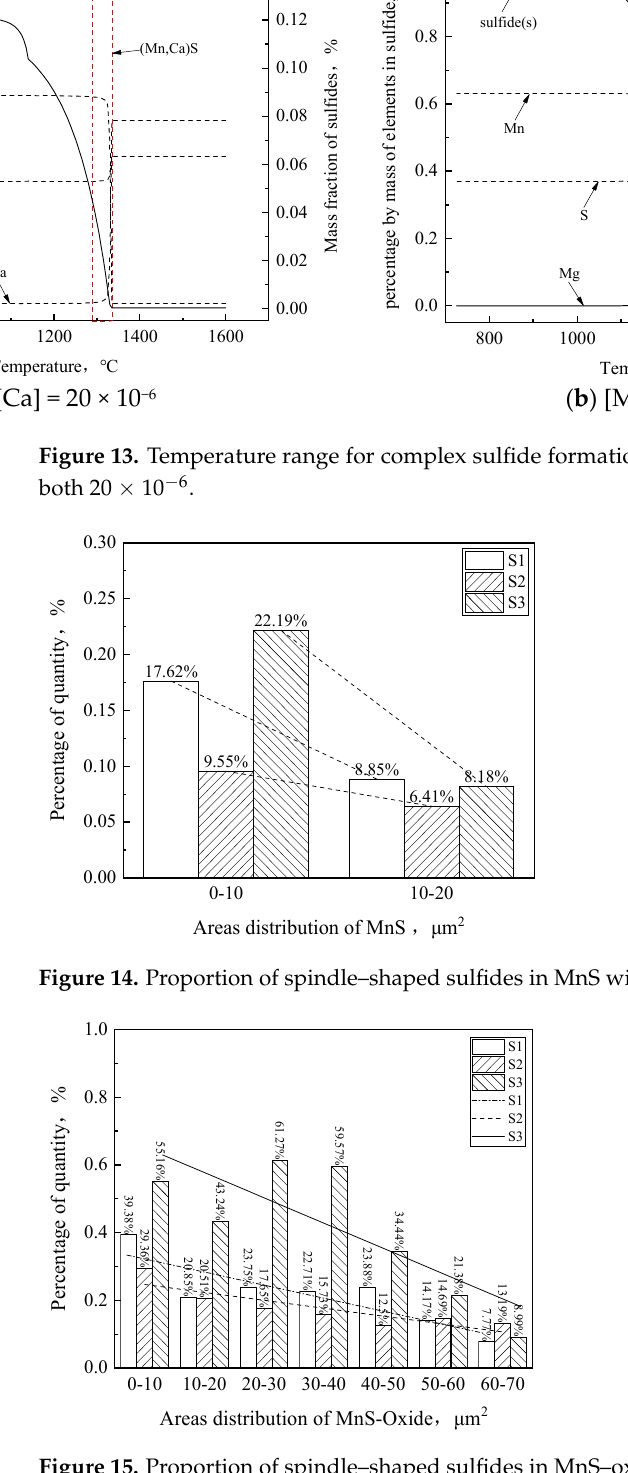
Figure 15. Proportion of spindle–shaped sulfides in MnS–oxide with different area sizes.